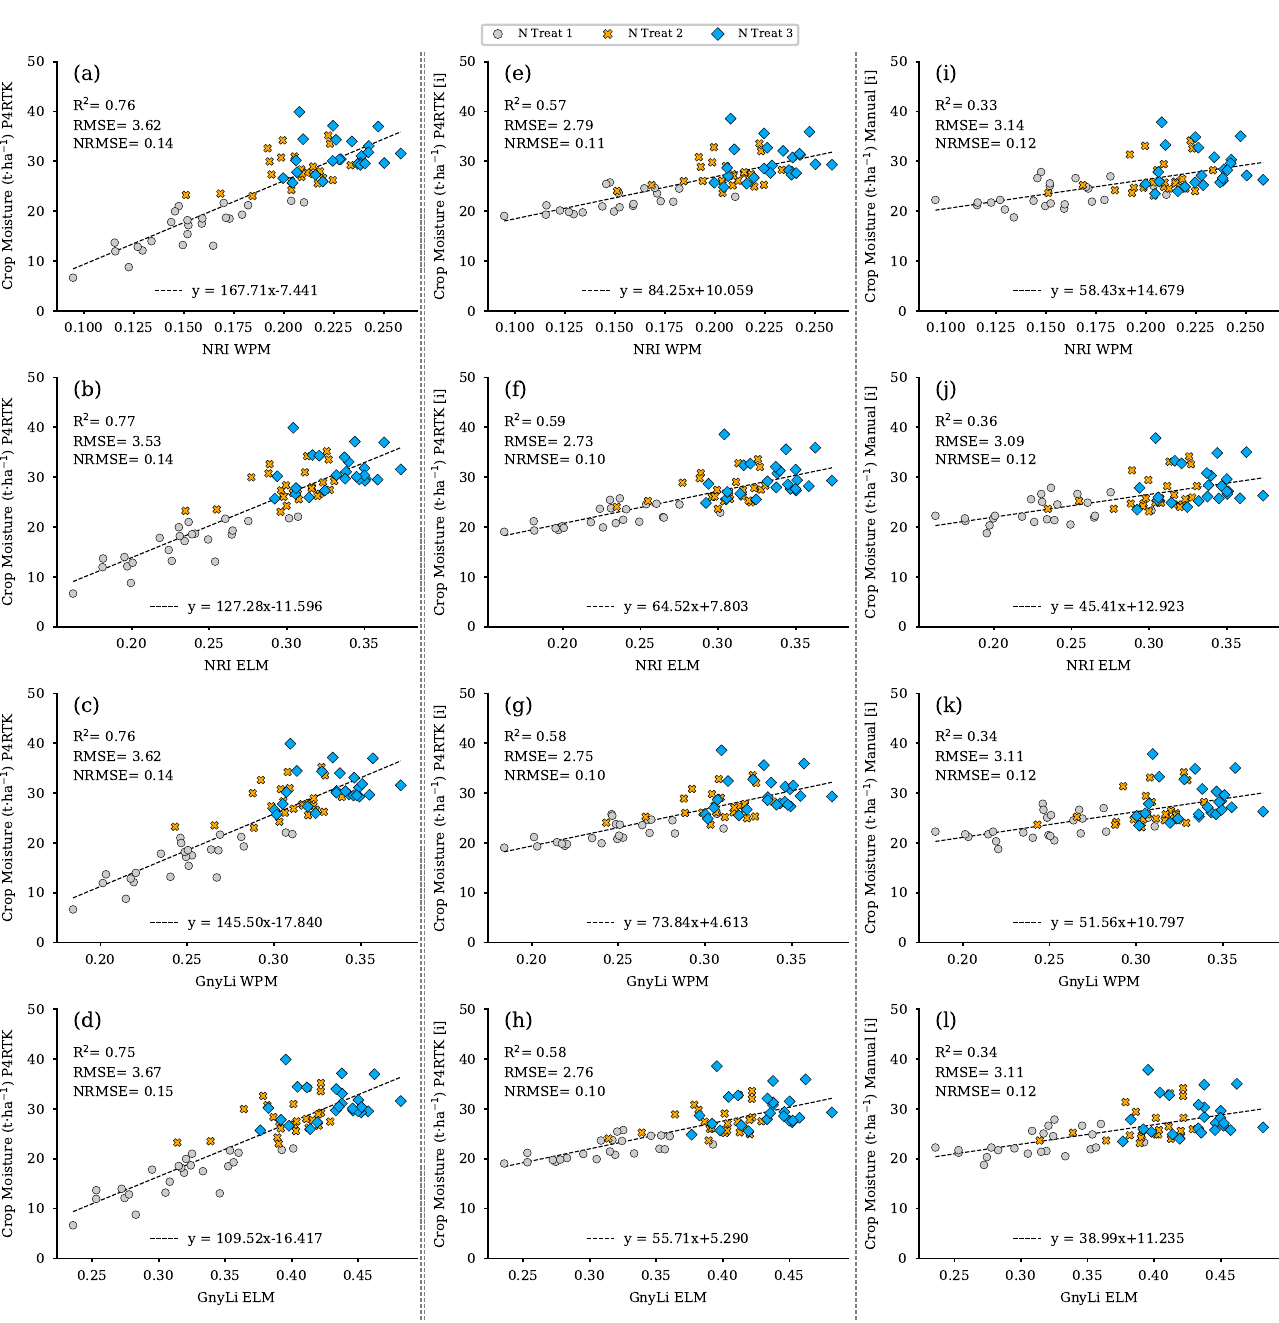
Figure 16. Scatter plots for the crop moisture (CM) data were estimated for the 72 non-destructive test plots with the CM model based on three different CH data sets with the spectral camera VIs acquired on 2 June. Left column: CH directly derived from P4RTK RGB data set of 2 June ( a – d ). Center column: linear interpolated CH from P4RTK RGB data set of 26 May and 12 June ( e – h ). Right column: linear interpolated CH manually measured on 26 May and 9 June ( i – l ). ( p < 0.001 for all regression